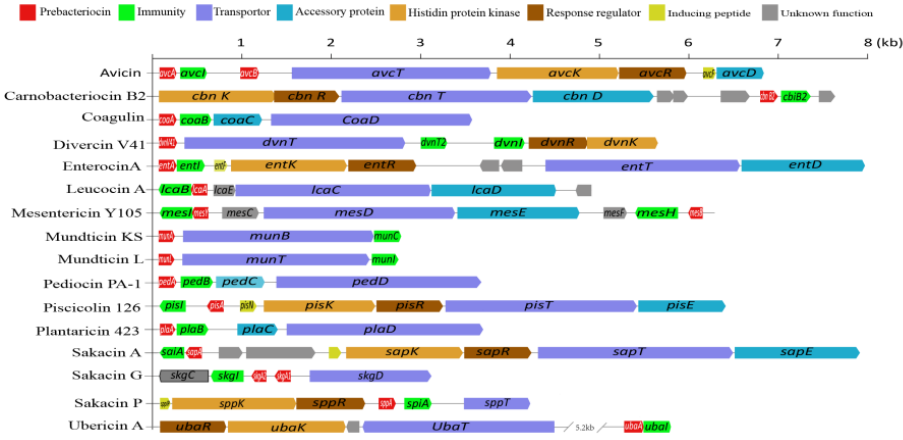
Figure 2. Organization of biosynthetic gene clusters of class IIa bacteriocins of LAB.